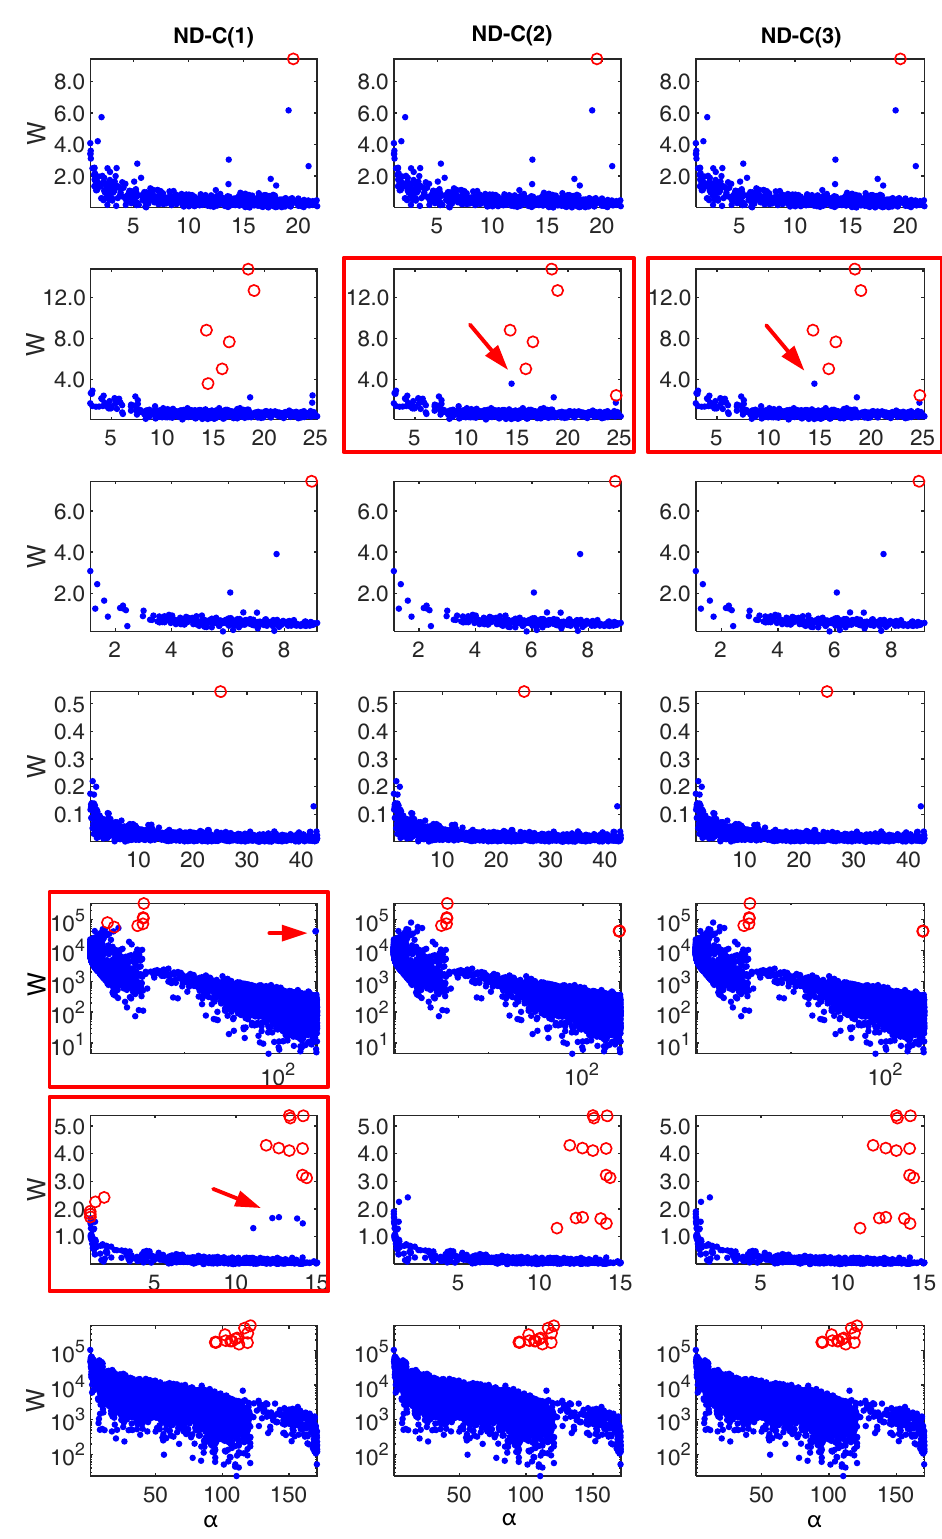
Figure 7. The 2-classification Decision Diagrams of ND-C(1), ND-C(2), and ND-C(3) on all the noise- contaminated test datasets shown in Figure 6. Each row shows the 2-classification Decision Diagrams of the test dataset shown in the same row of Figure 6. The blue points correspond to the edges that are not automatically removed by the cutting methods; the red points correspond to the edges that are automatically removed by the cutting methods. The red rectangles mark the 2-classification Decision Diagrams with falsely classified points, which are in blue and indicated by the red